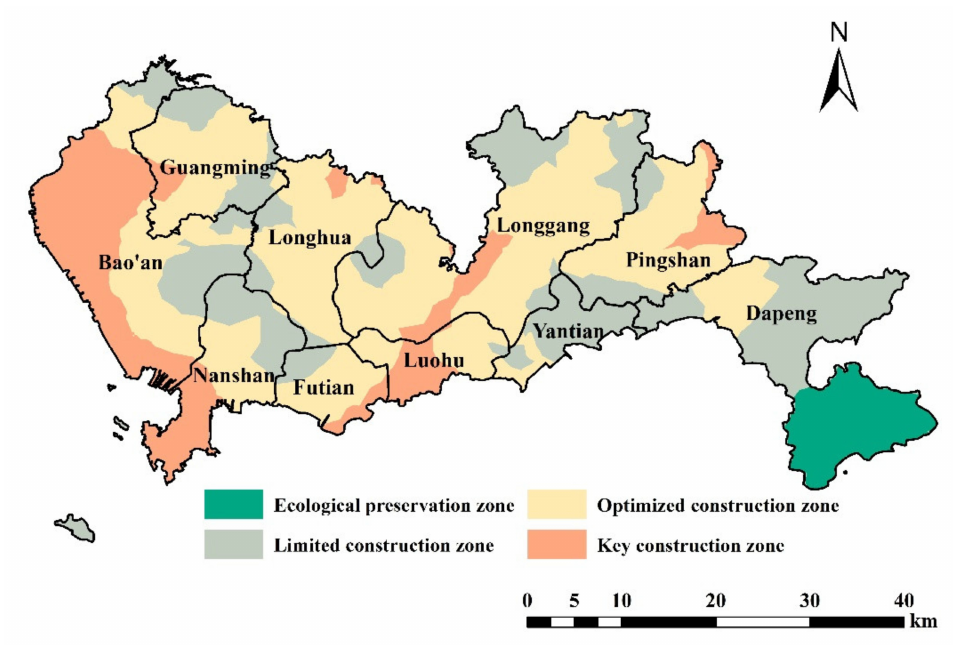
Figure 8. Ecological security zones in the study